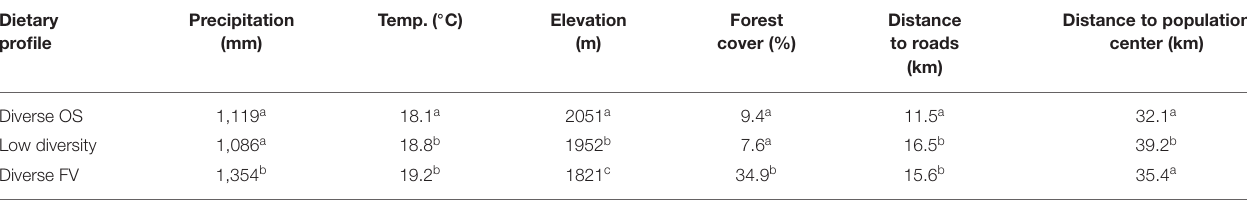
TABLE 5 | Landscape variables expected to influence dietary profiles. Dietary